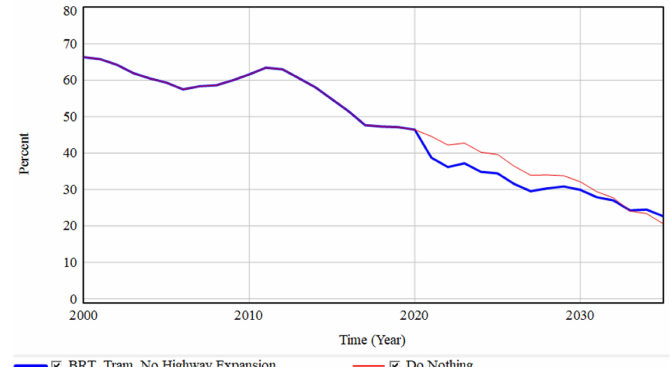
Fig. 4 Comparison of simulation result of travel time efficiency for BRT and tram projects without highway expansion scenario